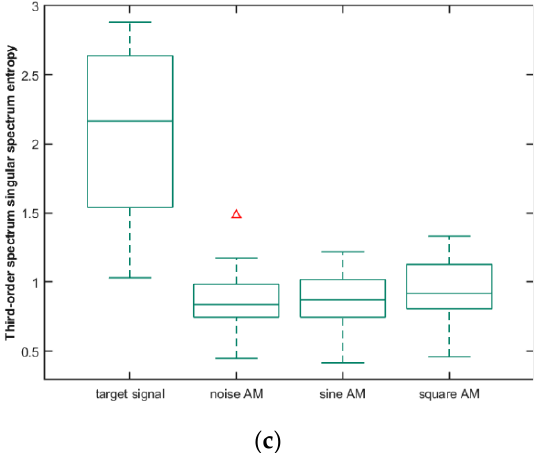
Figure 5. Box diagram of different signal features. ( a ) Box diagram of three order spectrum average amplitude feature; ( b ) Box diagram of three order spectrum entropy feature; ( c ) Box diagram of three order spectrum singular spectrum entropy feature.